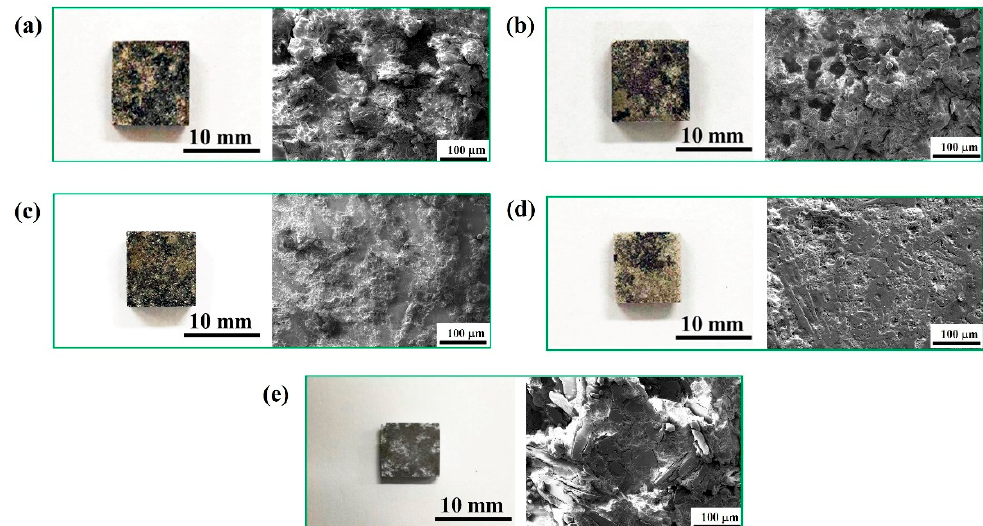
Figure 8. Optical and SEM corrosion morphologies of the cast and coated samples after hydrogen-evolution immersion in NaCl solution: ( a ) uncoated sample; ( b ) 120 °C-coated sample; ( c ) 130 °C-coated sample; ( d ) 140 °C-coated sample; ( e ) 150 °C-coated sample.